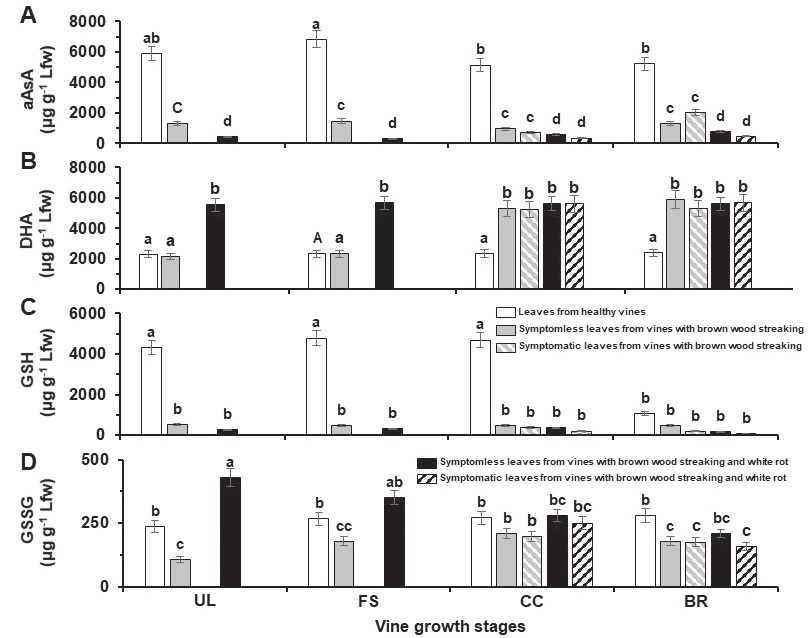
Figure 4. Ascorbic acid (aAsA; A), dehydroascorbic acid (DHA; B), reduced (GSH; C) and oxidized (GSSG; D) glutathione concentrations of ‘Italia’ leaves collected during the unfolded leaf (UL), fruit set (FS), cluster closing (CC) and bunch ripening (BR) vine growth stages, from infected or healthy vines. Data are the means of 50 replicates ± standard deviations. For each parameter, values accompanied by the same letters are not significantly different ( P ≤ 0.05) according to Fisher’s LSD